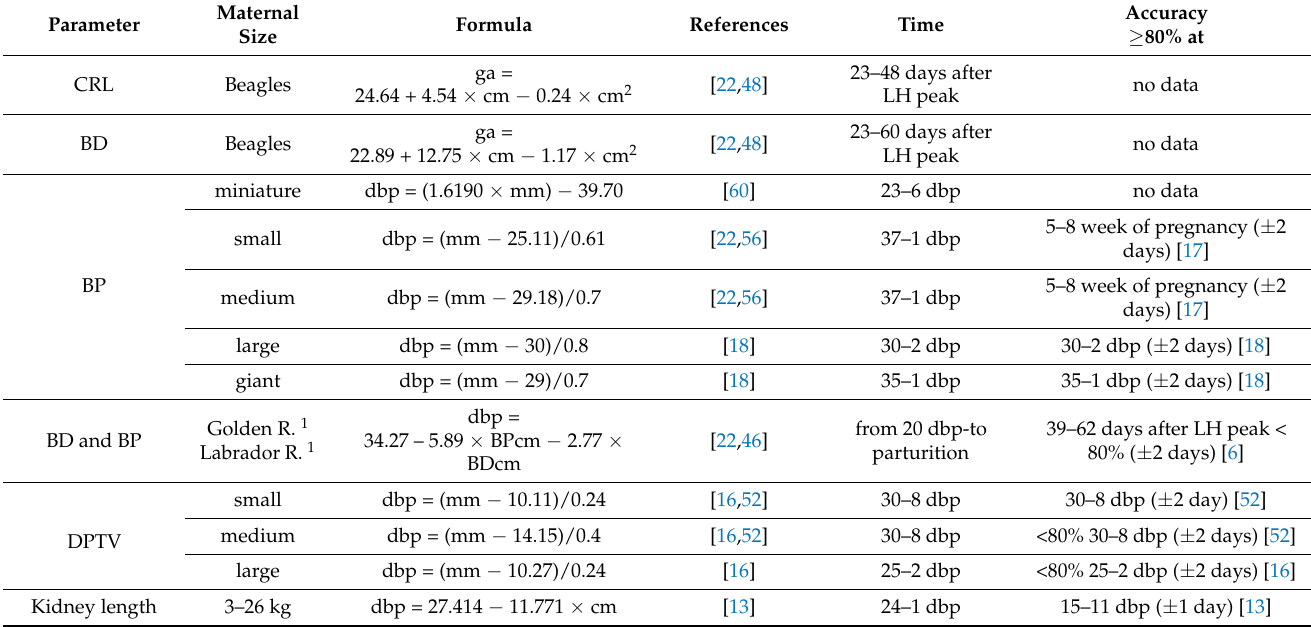
Table 4. Formulas for calculations of days before parturition (dbp) or gestational age (ga: days after LH peak) in bitches of different size (miniature ≤ 5 kg, small ≤ 10 kg, medium 11 to 25 kg, large 26 to 40 kg, and giant > 40 kg [16,18,59]) for crown-rump length (CRL), body diameter (BD), biparietal diameter (BP), deep portion of diencephalo-telencephalic vesicle (DPTV) and kidney length. The measurements (scale either in mm or cm) are the mean of BD orthogonal measurements in all measured fetuses. References are reported in brackets. Time of measurement refers to the dbp or days after LH peak in which each parameter was calculated. When available, dbp or week of pregnancy in which accuracy was ≥ 80% ( ± 1 or ± 2 days) is also